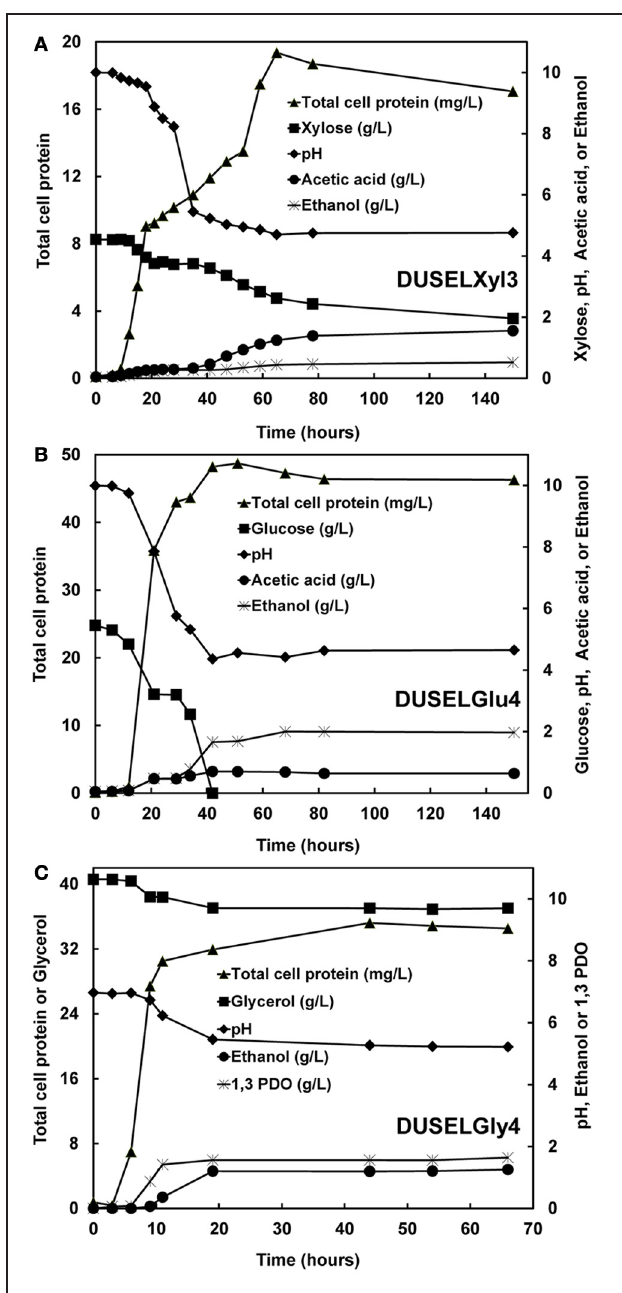
FIGURE 2 | Profiles of total cell protein, substrate consumption, change in pH, and product formation during the fermentation by DUSELXyl3 (A), DUSELGlu4 (B), and DUSELGly4 (C).